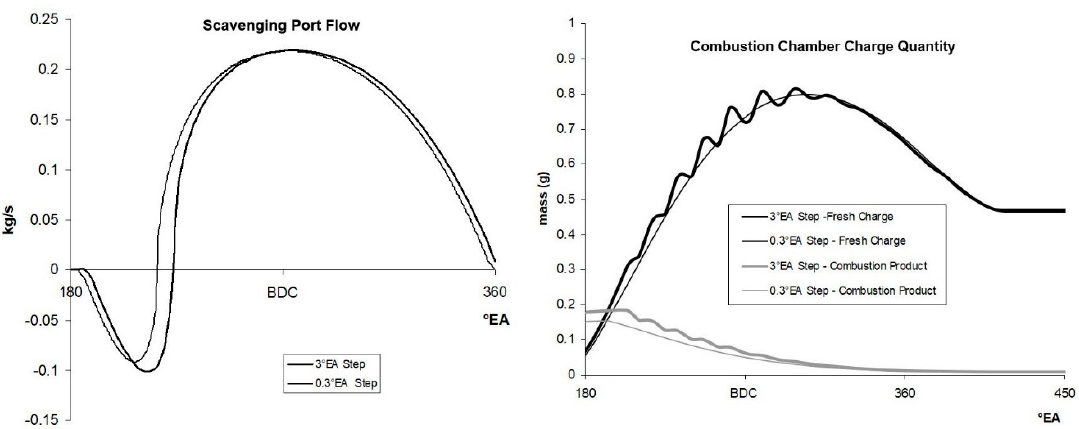
Figure 8. Effect of time step on scavenging port flow and combustion chamber charge quantity (2.5 bar charge pressure, 4000 rpm).